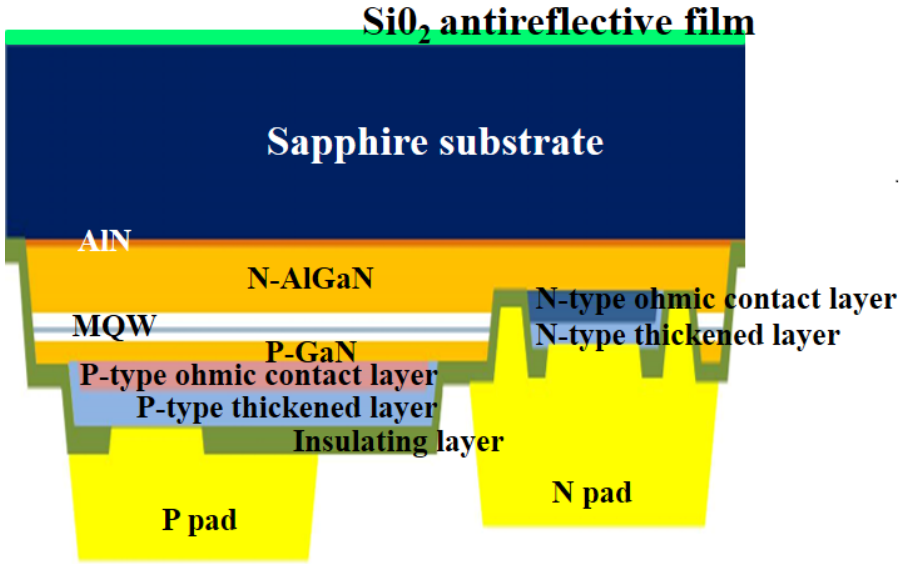
Figure 1. Device structure of UVC-LED with anti-reflective SiO 2 .